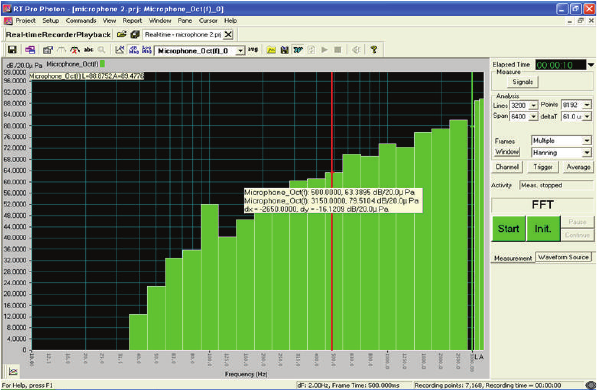
Figure 11: Variation of noise (dB) with frequency (Hz) at 1200rpm for 6Kg load with phasing.